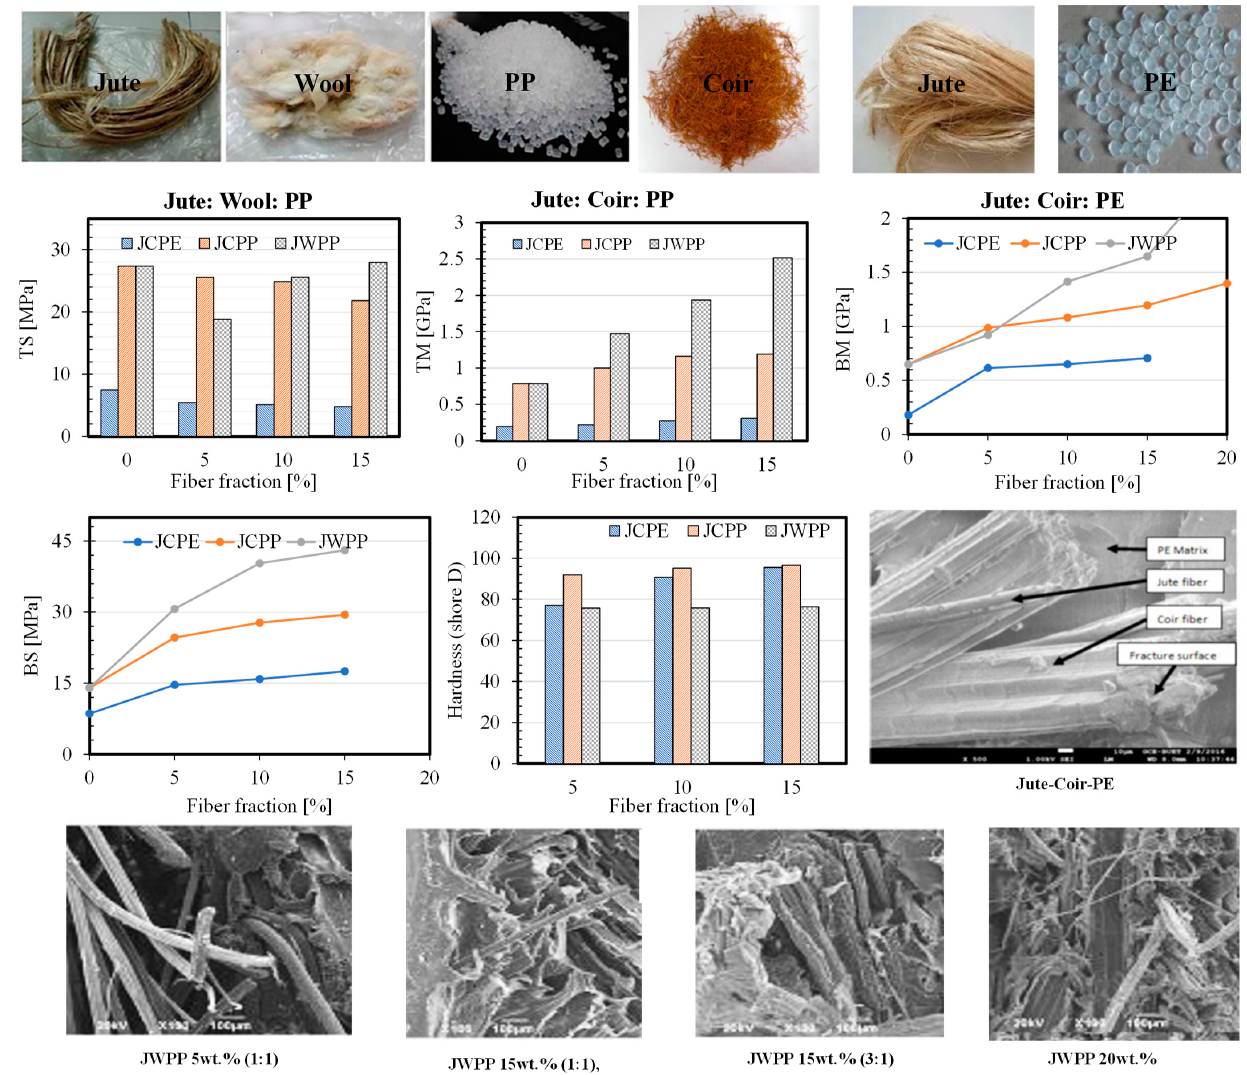
Figure 20. Effect of natural fiber hybridization on jute composite [71–73]. Synthetic glass/carbon fiber reinforced polymer composites are mostly used due to their uniform properties, high strength, durability but their non-biodegradability and non-renewability forces efforts to find alternatives. Natural fibers like jute can be incorpo- rated with the GFRP/CFRP to minimize the use of synthetic fibers while maintaining rea- sonably good mechanical strength [70,77–80]. The content of synthetic fiber is more influ- ential in defining the mechanical performance than the stacking sequence between the synthetic and jute fibers [81]. Therefore, appropriate tailoring of jute fiber composites with synthetic fibers could provide a balance between cost, performance and environmental impact [82]. Some nanofiller (carbon nanotube, graphene,) incorporation in the jute composite can increase performance which will create a new area of research [83,84]. Hybrid jute com- posites with a mixture of two matrixes such as reinforced polyvinyl chloride (PVC) and polypropylene (PP) were also prepared by compression molding. A mixture of 60% PP and 40% PVC matrixes was recommended for the best performance [85].